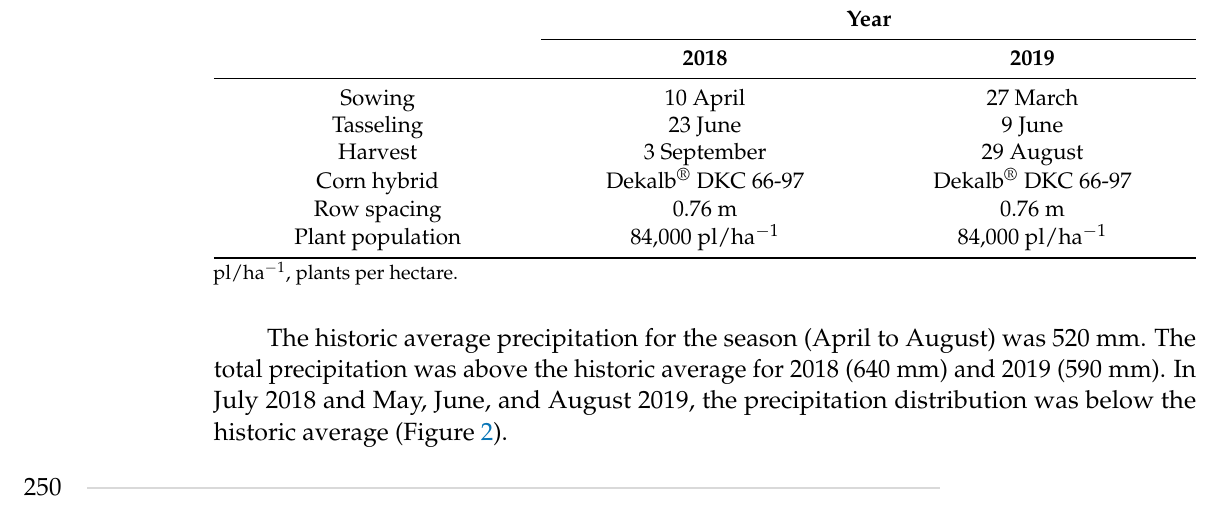
Figure 2. Total precipitation (average from 1999 – 2019, 2018, and 2019) during the growing seasons. A Vantage Pro 2 Plus weather station (model 6163, Davis Instruments, Hayward, CA, USA) located close to the field was used to record the precipitation data. Adapted from [42].